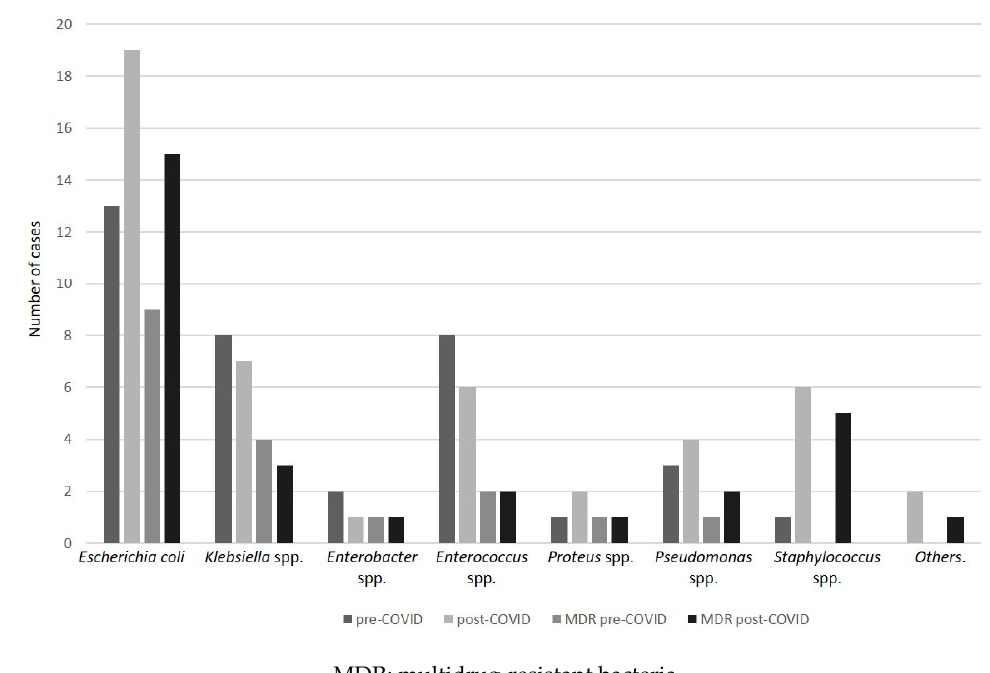
Figure 2. Number of total cases for each bacterium in accordance with the period (pre- and post-COVID-19) and number of MDR isolated bacteria in pre- and post-COVID-19 period.